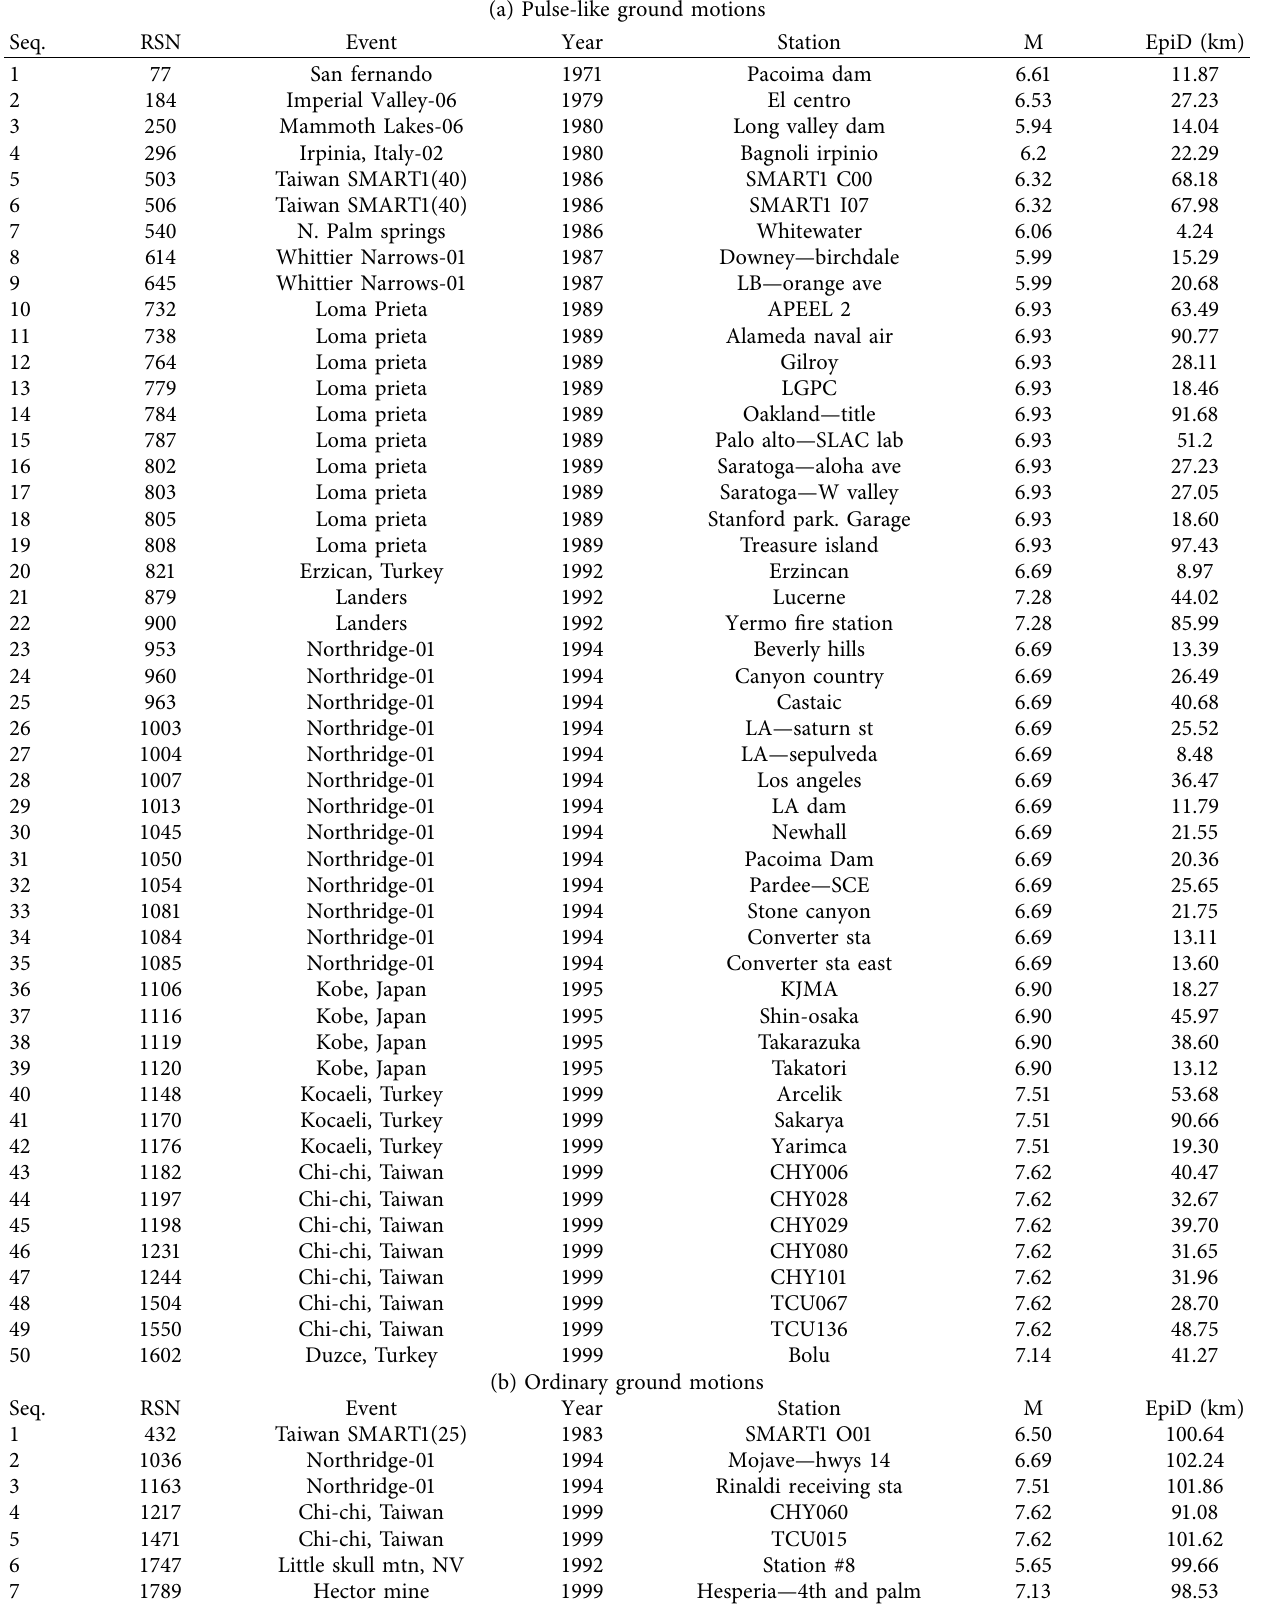
Table 1: Selected ground